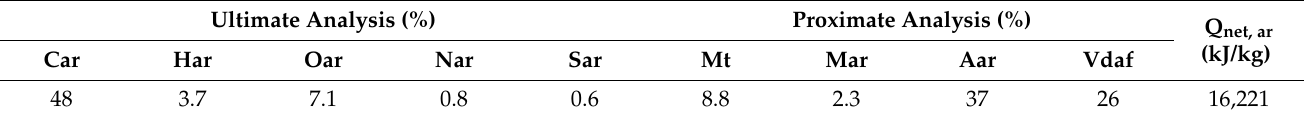
Table 2. Analysis of the combusted